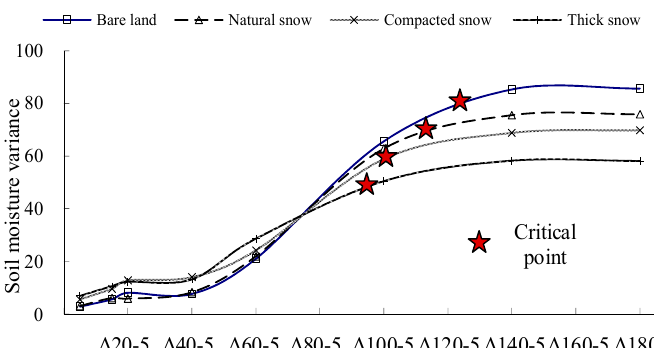
Figure 8. Variation in soil water content.